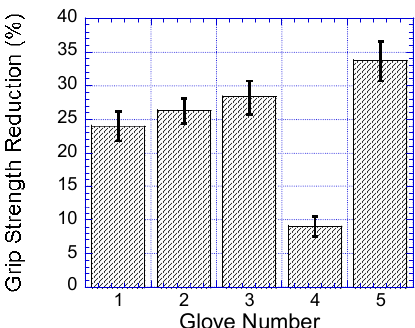
Figure 7. Comparison of mean grip strength percentage reduction of the five gloves when compared to the bare-hand grip strength. Bar errors represent the standard deviations.